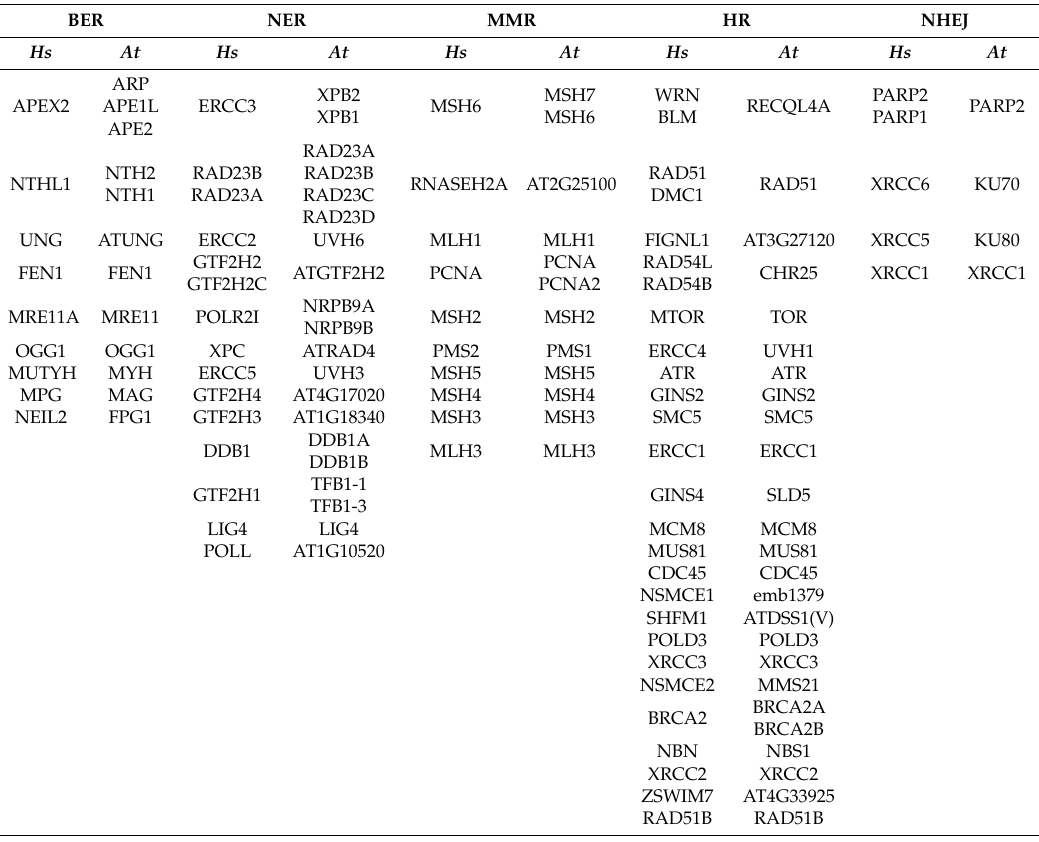
Table 6. Sets of retrieved orthologous genes between Homo sapiens (Hs) and Arabidopsis thaliana (At) suggested to be implicated in the five main DNA repair mechanisms. For GO terms refer to Table 4. BER, base excision repair; NER, nucleotide excision repair; MMR, mismatch repair; HR, homologous recombination; NHEJ, non-homologous end